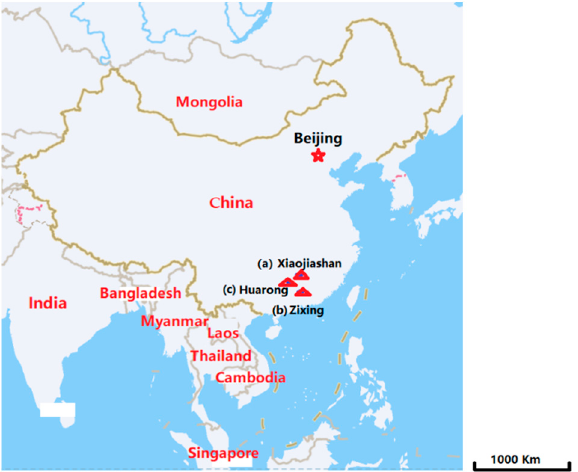
Figure 2. Geographic location map of surveys, ( a ) Xiaojiashan Reservoir leakage survey, ( b ) Zixing groundwater detection survey, ( c ) Huarong groundwater detection survey.